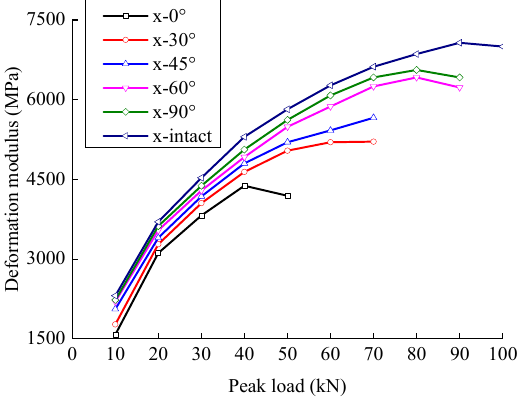
Figure 4. Relationship between elastic modulus and load level.